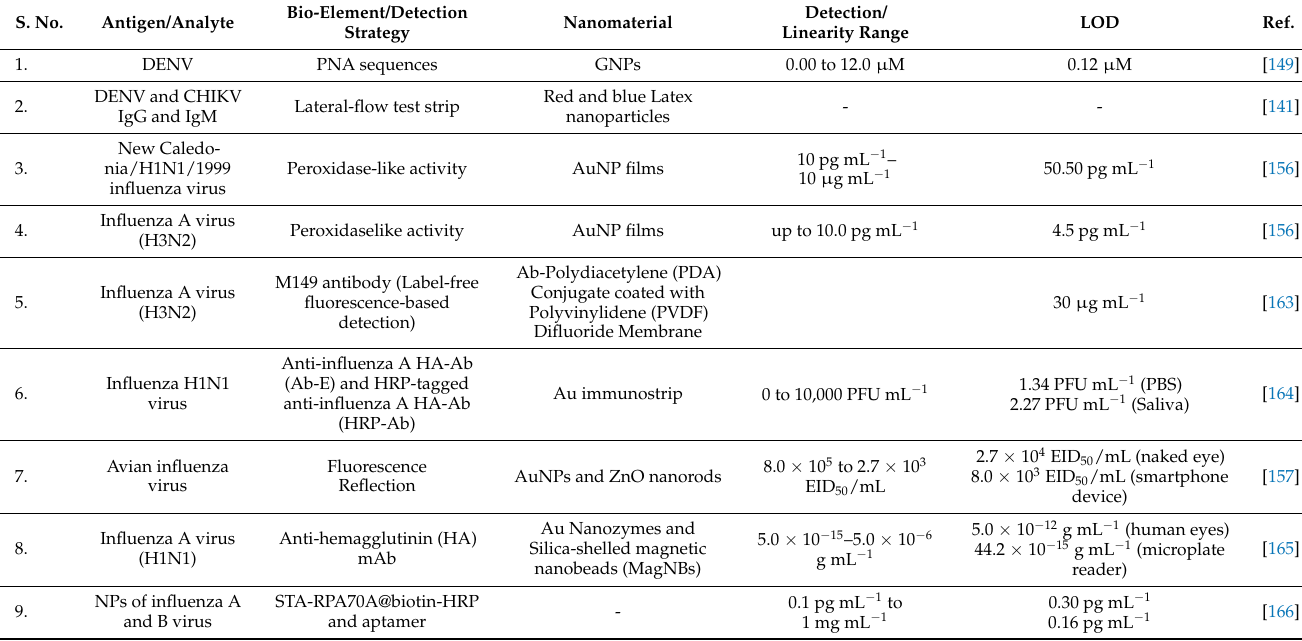
Table 1. Reported colorimetric-based sensing platform for viral